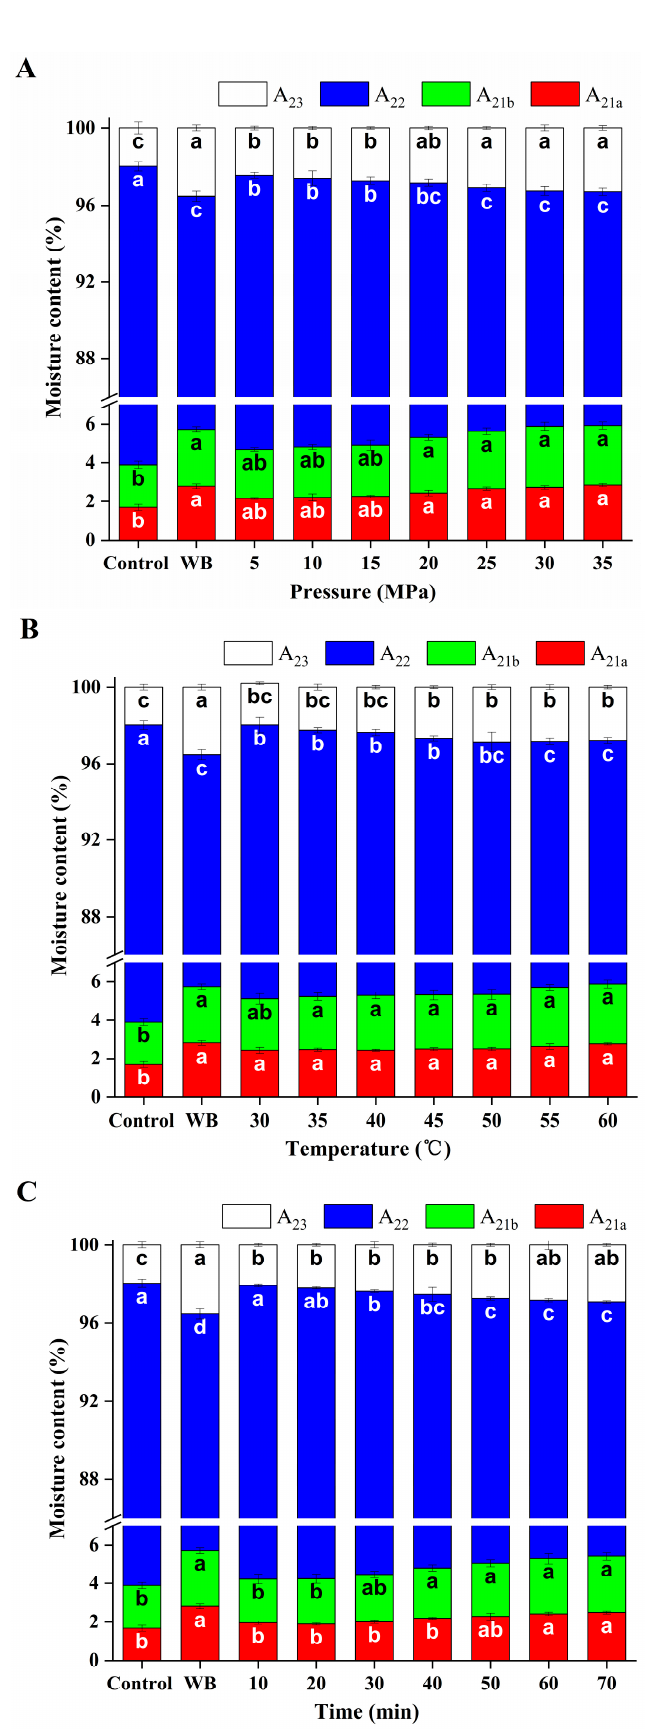
Figure 5. Effect of different DPCD treatments on the different states of the water content in surimi ( A ): Pressure, ( B ): Temperature, ( C ): Time. Different letters indicate statistically significant differences ( p < 0.05).